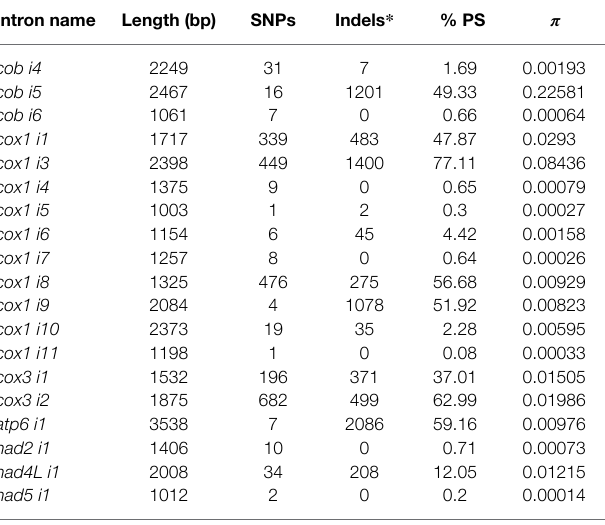
TABLE 3 | Variation in conserved mitochondrial introns among fungal